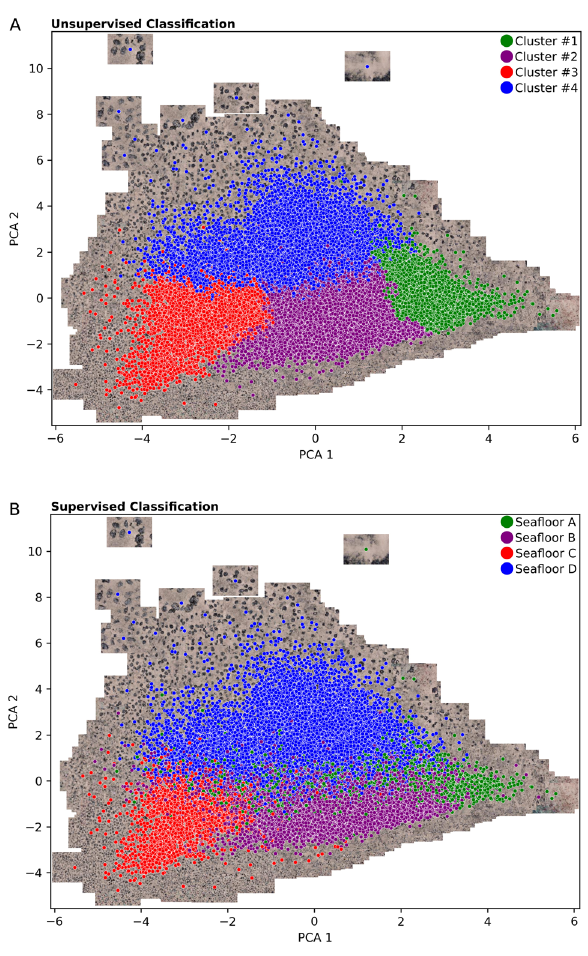
Figure 7. PCA projection of all images onto feature space color coded by results of ( A ) unsupervised classification and, ( B ) supervised